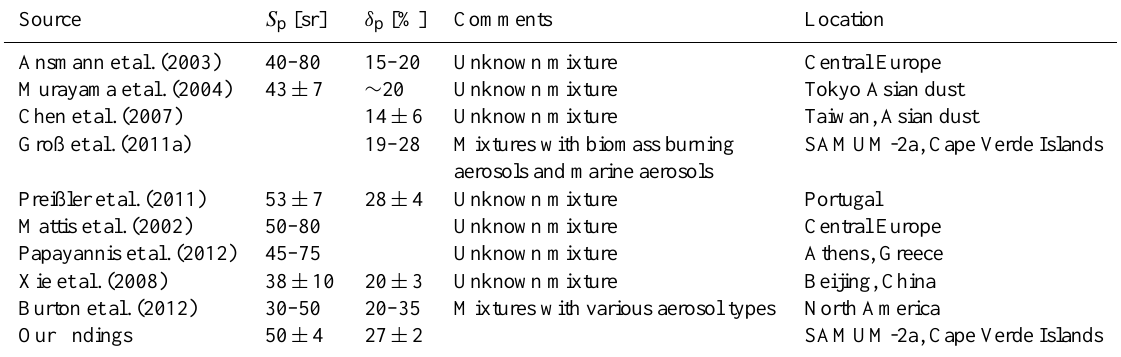
Table 5. Summary of the key findings concerning the lidar ratio ( S p ) and the particle linear depolarization ratio ( δ p ) found for desert dust